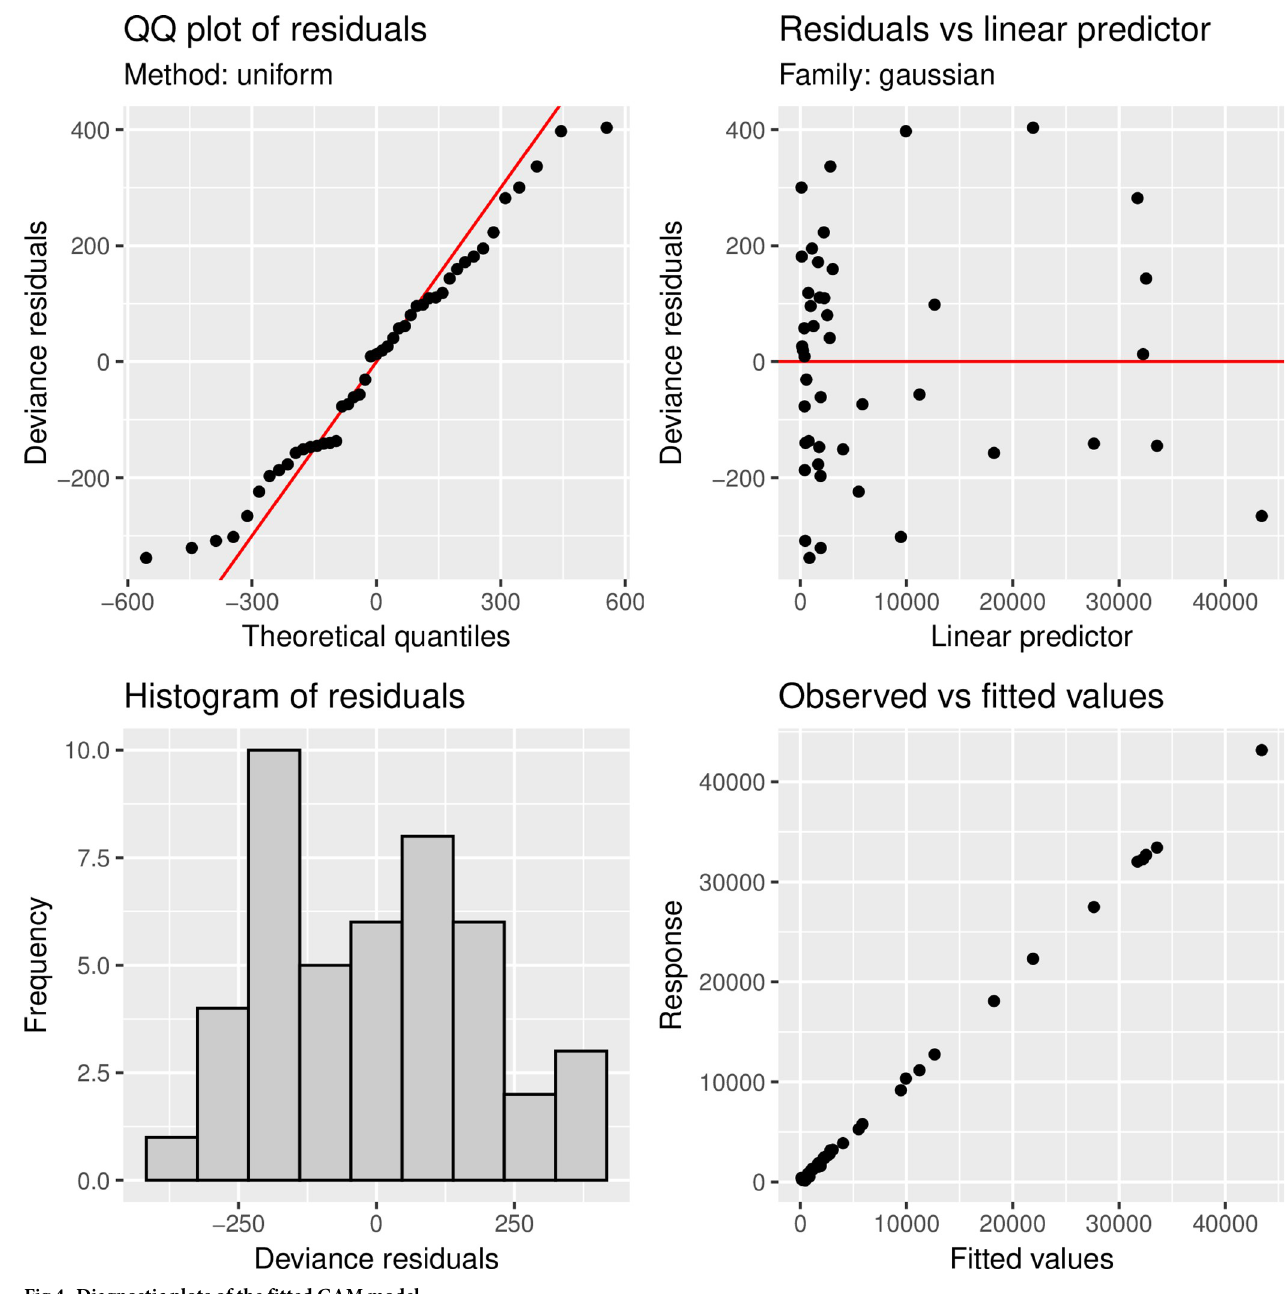
Fig 4. Diagnostic plots of the fitted GAM